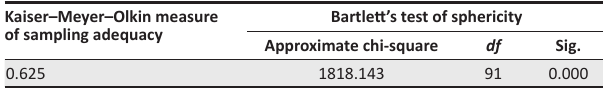
TABLE 2: Kaiser-Meyer-Olkin and Bartlett’s test.